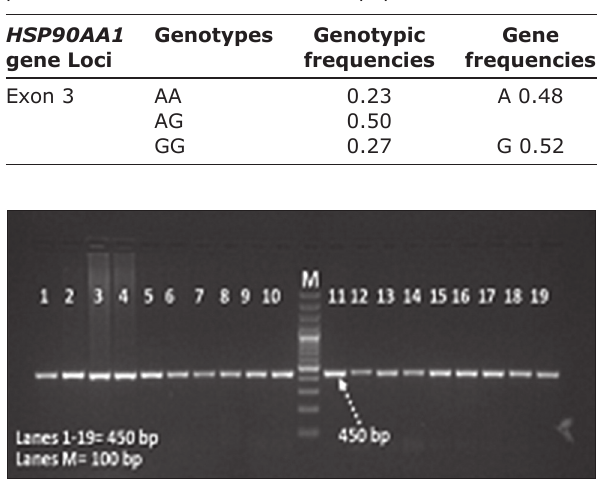
Figure 1: PCR amplification of exon 3 of HSP90AA1 gene in Sahiwal cow (M=100bp)